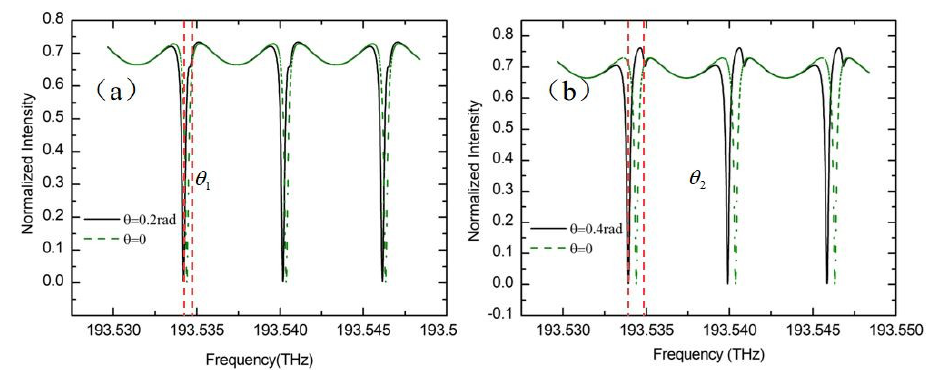
Figure 15. Considering the backreflection noise, ( a ) the resonance curve in the case of Sagnac phase shift is 0.2 rad , and ( b ) the resonance curve in the case of the Sagnac phase shift is 0.4 rad can be obtained.